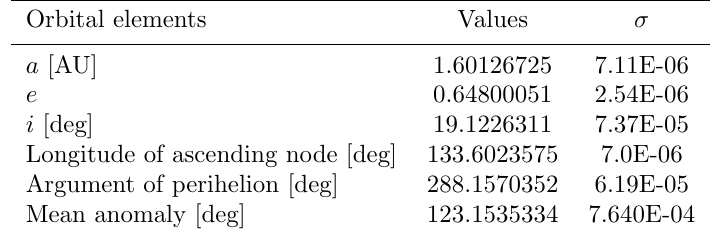
Fig. 2. The orbit of 2008 OS9 in the ecliptic plane. Positions of the asteroid and planets are presented for the date of discovery, 2008-07-30. The dashed line denotes the part of the orbit below the ecliptic plane. Table 2. The orbit of 2008 OS9 calculated with the OrbFit software with the 1 (cid:27) errors (rms) of the parameters. Epoch: JD 2455000.5 TDT = 2009-06-18, rms = 0.519 ′′